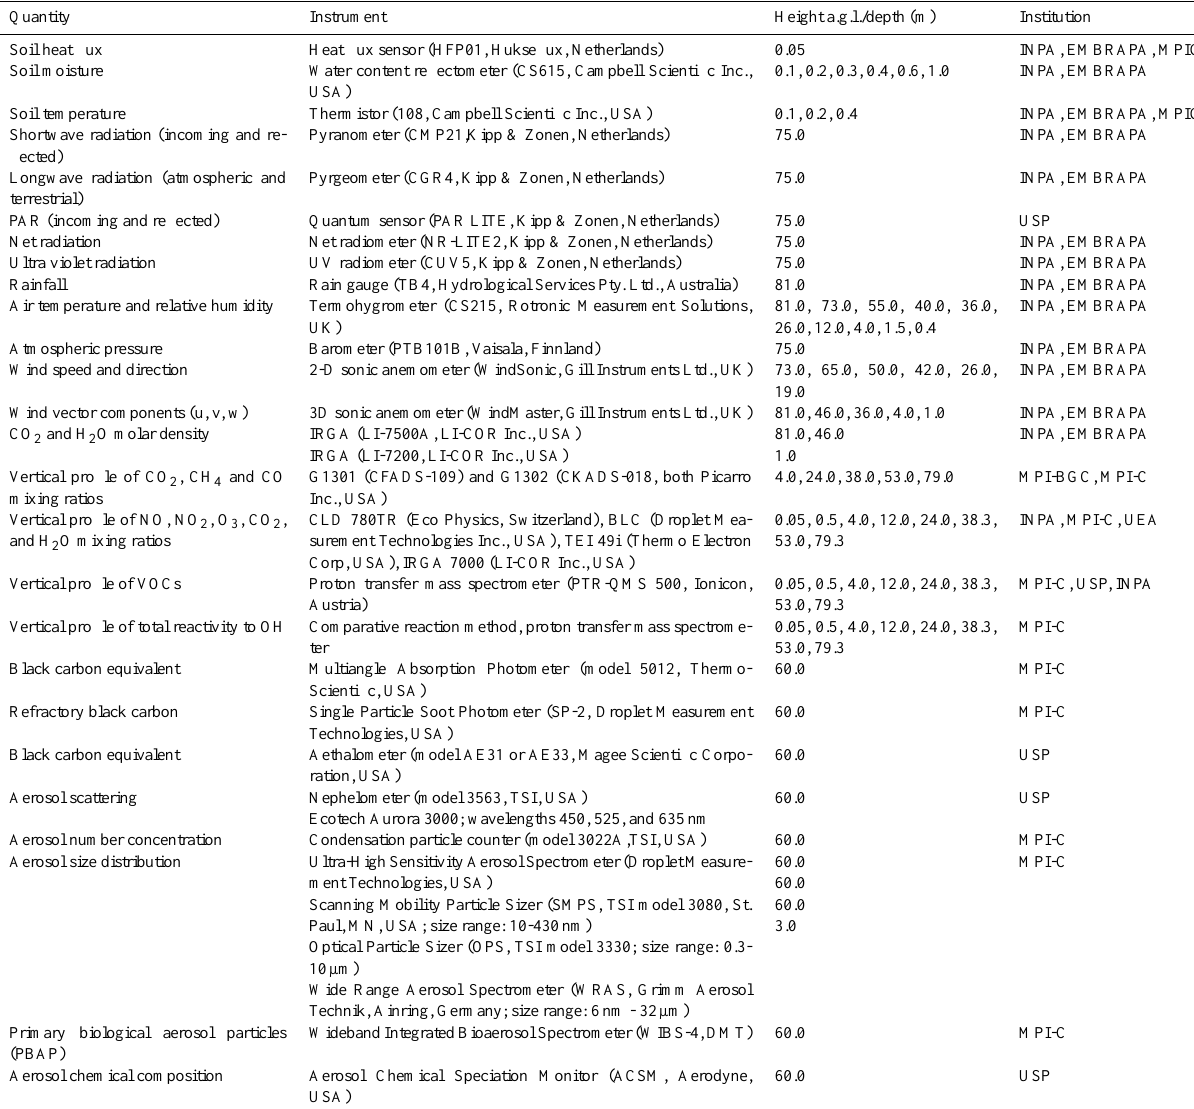
Table 2. Overview of (micro)-meteorological sensors, trace gas and aerosol instrumentation installed at the walk-up tower.